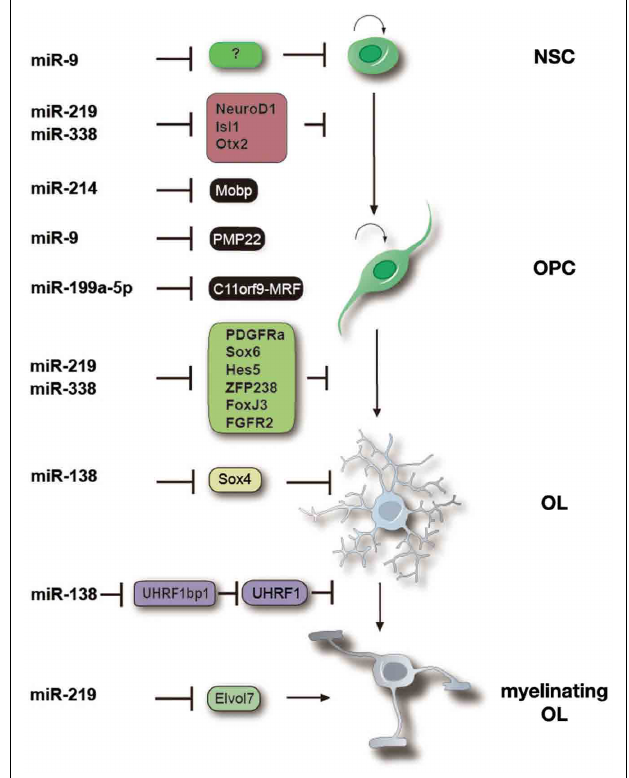
FIGURE 2 | miRNAs function at multiple stages to control oligodendrocyte differentiation and myelination. Specific miRNAs involved in regulating the neural precursor to OPC transition, OPC differentiation, OL maturation and myelination as well as the documented and predicted targets of those miRNAs are shown. miR-9, miR-214, and miR-199a-5p are highly expressed in OPCs and prevent premature differentiation by blocking expression of myelin components including Mobp, PMP22 and maturation promoting factors such as MRF/C11orf9. miR-138, -219 and -338 are more highly expressed in OLs and promote OL differentiation by inhibiting expression of differentiation inhibitors (e.g., Hes5, Sox6, and Sox4) and proliferation signaling molecules such as PDGFR α and FGFR, as well as neuronal differentiation factors (e.g., Zfp238 and FoxJ3). miR-219 may also regulate OL terminal maturation and myelin maintenance by targeting fatty acid elongases such as Elvol7.The expression pattern of miRNAs is likely correlated to their functions at different stages of OL lineage